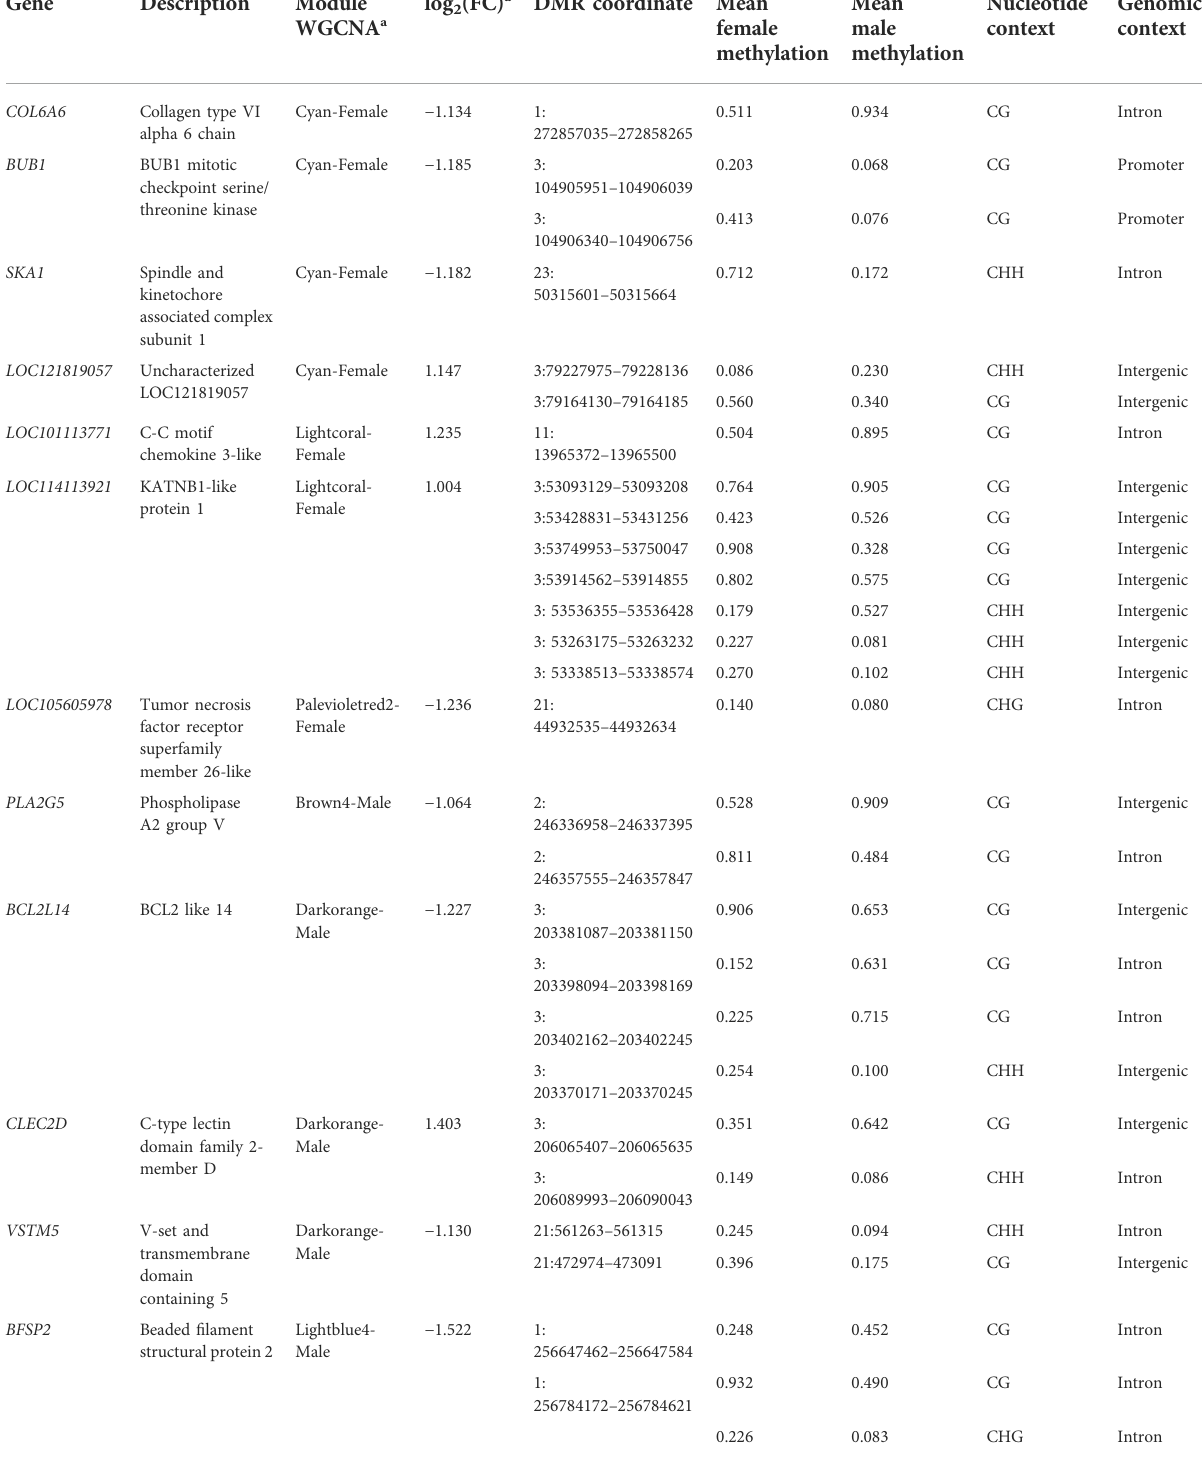
TABLE 3 Sex discriminant genes identi fi ed by the multiblock (s)PLS-DA* discriminant analysis. These genes were allocated in differentially coexpressed modules from the weighted correlation network analysis (WGCNA)*, and were signi fi cantly correlated with the fat percentage in different adipose deposits (Renal, Pelvic, Renal and Pelvic, Leg subcutaneous, and Leg intramuscular). For each gene is indicated: their symbol, the description, the coexpression module, the fold change (base 2 logarithm), the DMR location in the reference genome (chromosome: coordinates), the proportion of methylation in females and males, and the sequence and genomic